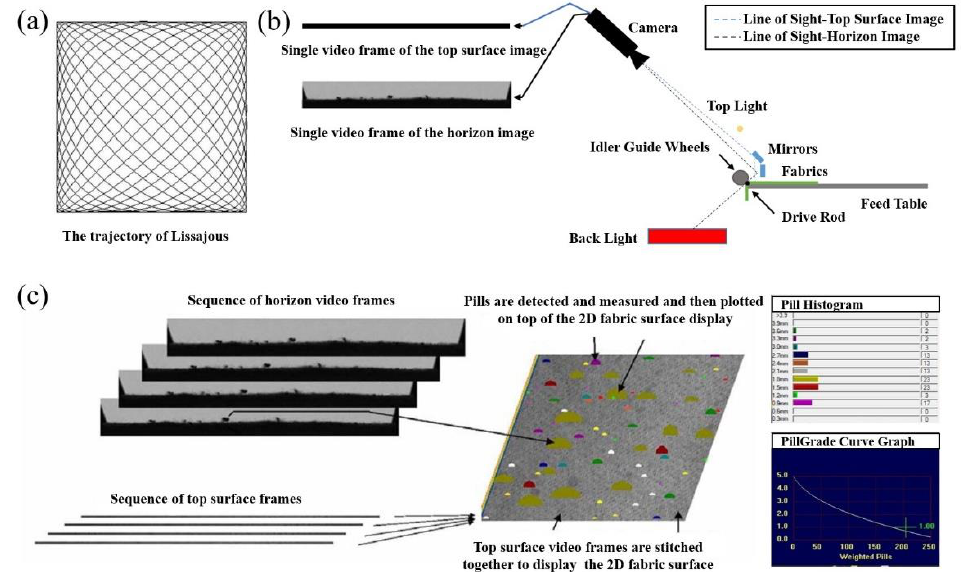
Figure 1. Test and evaluation of pilling performance. ( a ) the trajectory of Lissajous; ( b ) the process of rolling over fabric samples and capturing sample images in a video recorder; ( c ) the graph using semicircular markers color-coded by pill size.